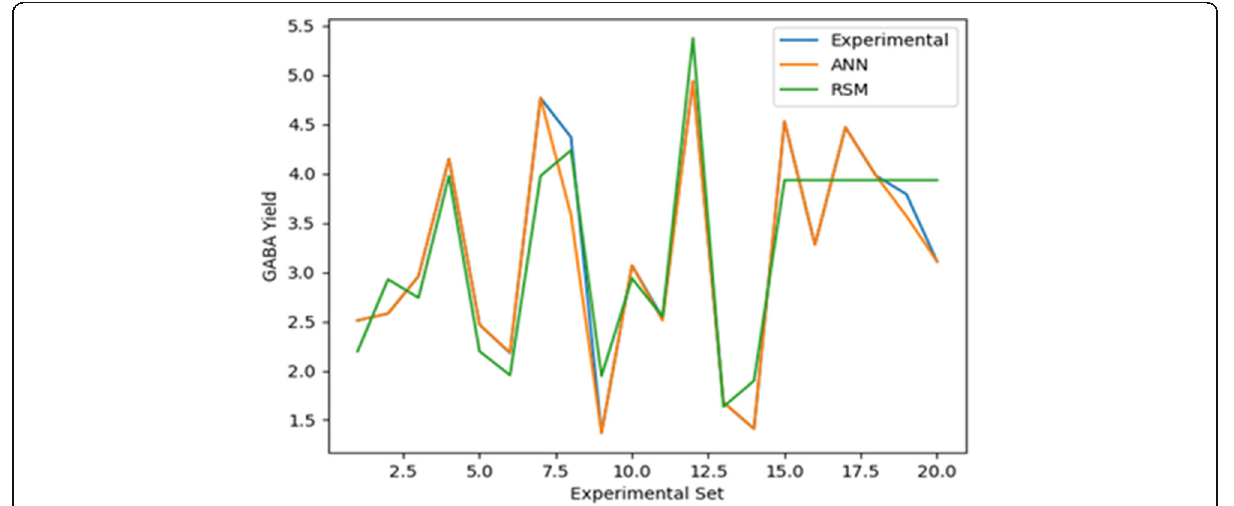
Fig. 9 Comparative plots of experimental data with RSM and ANN